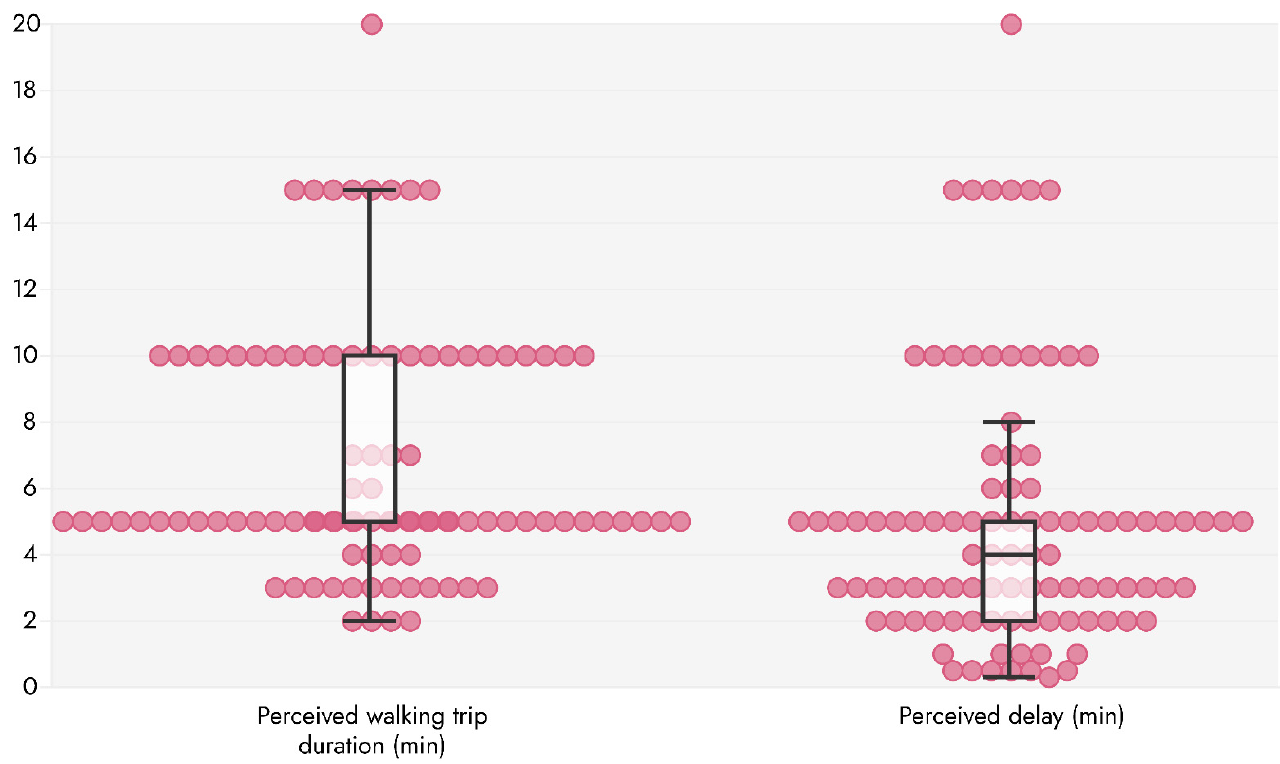
Table 2. Descriptive statistics of the variables used.